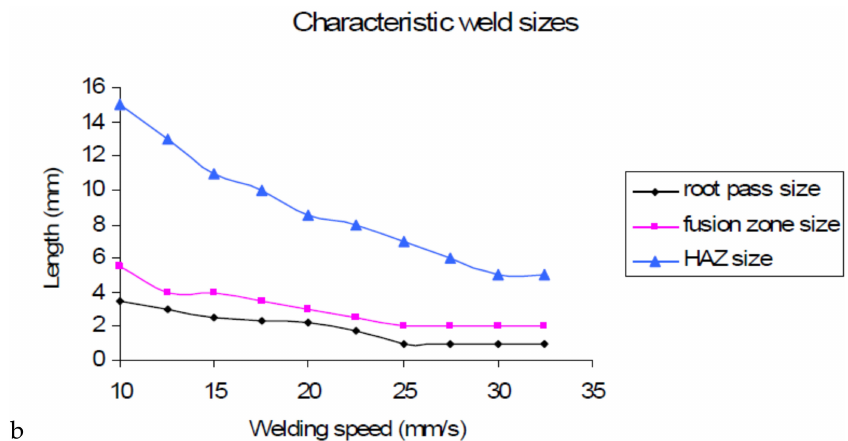
Figure 4. ( a ) Schematic representation of the weld profiles for similar welding 16CrMn4 for